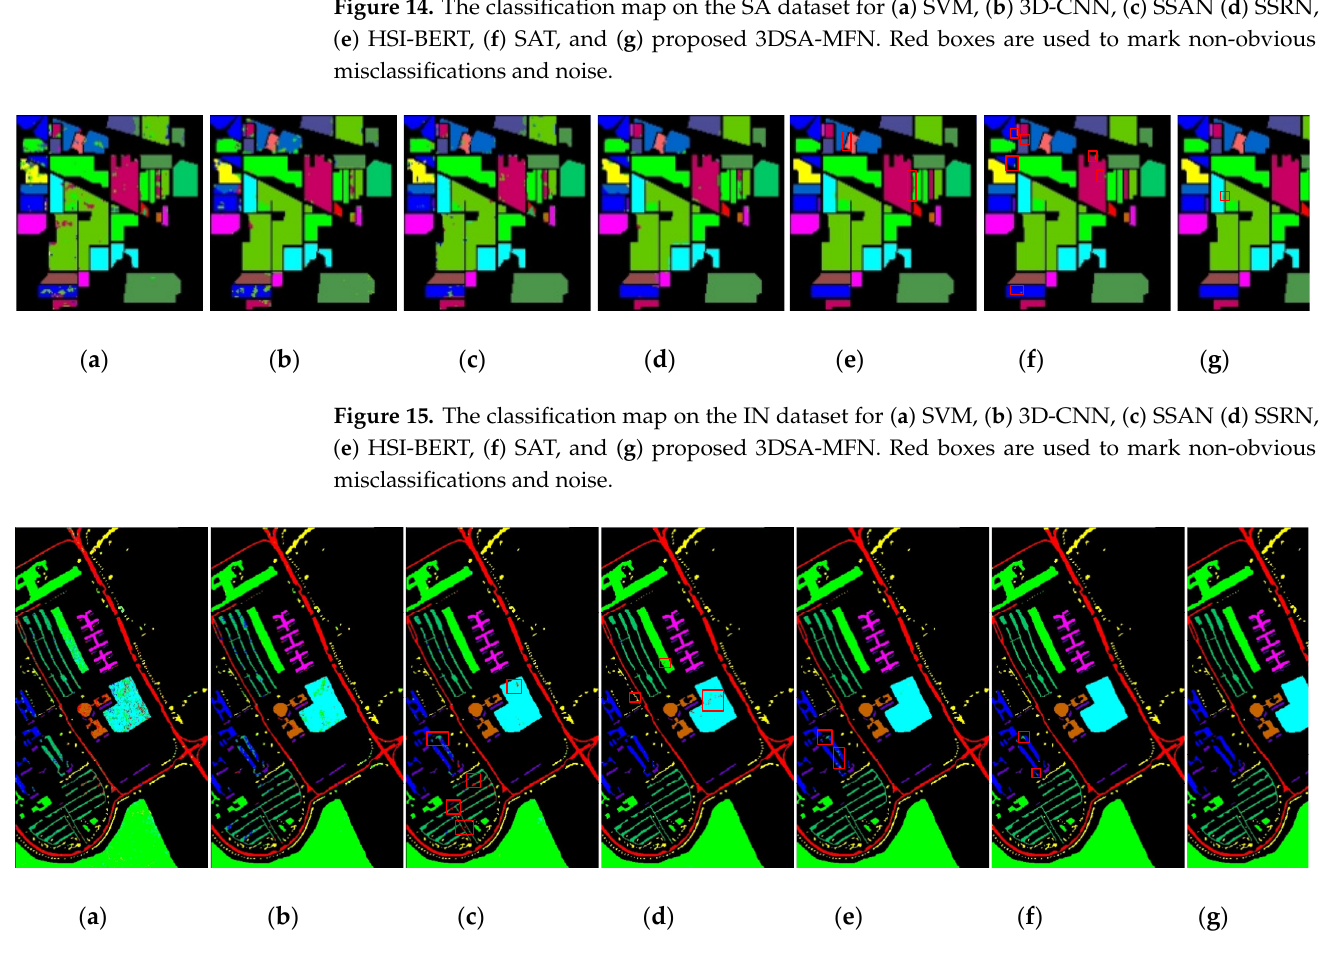
Figure 16. The classification map on the UP dataset for ( a ) SVM, ( b ) 3D-CNN, ( c ) SSAN ( d ) SSRN, ( e ) HSI-BERT, ( f ) SAT, and ( g ) proposed 3DSA-MFN. Red boxes are used to mark non-obvious misclassifications and noise.